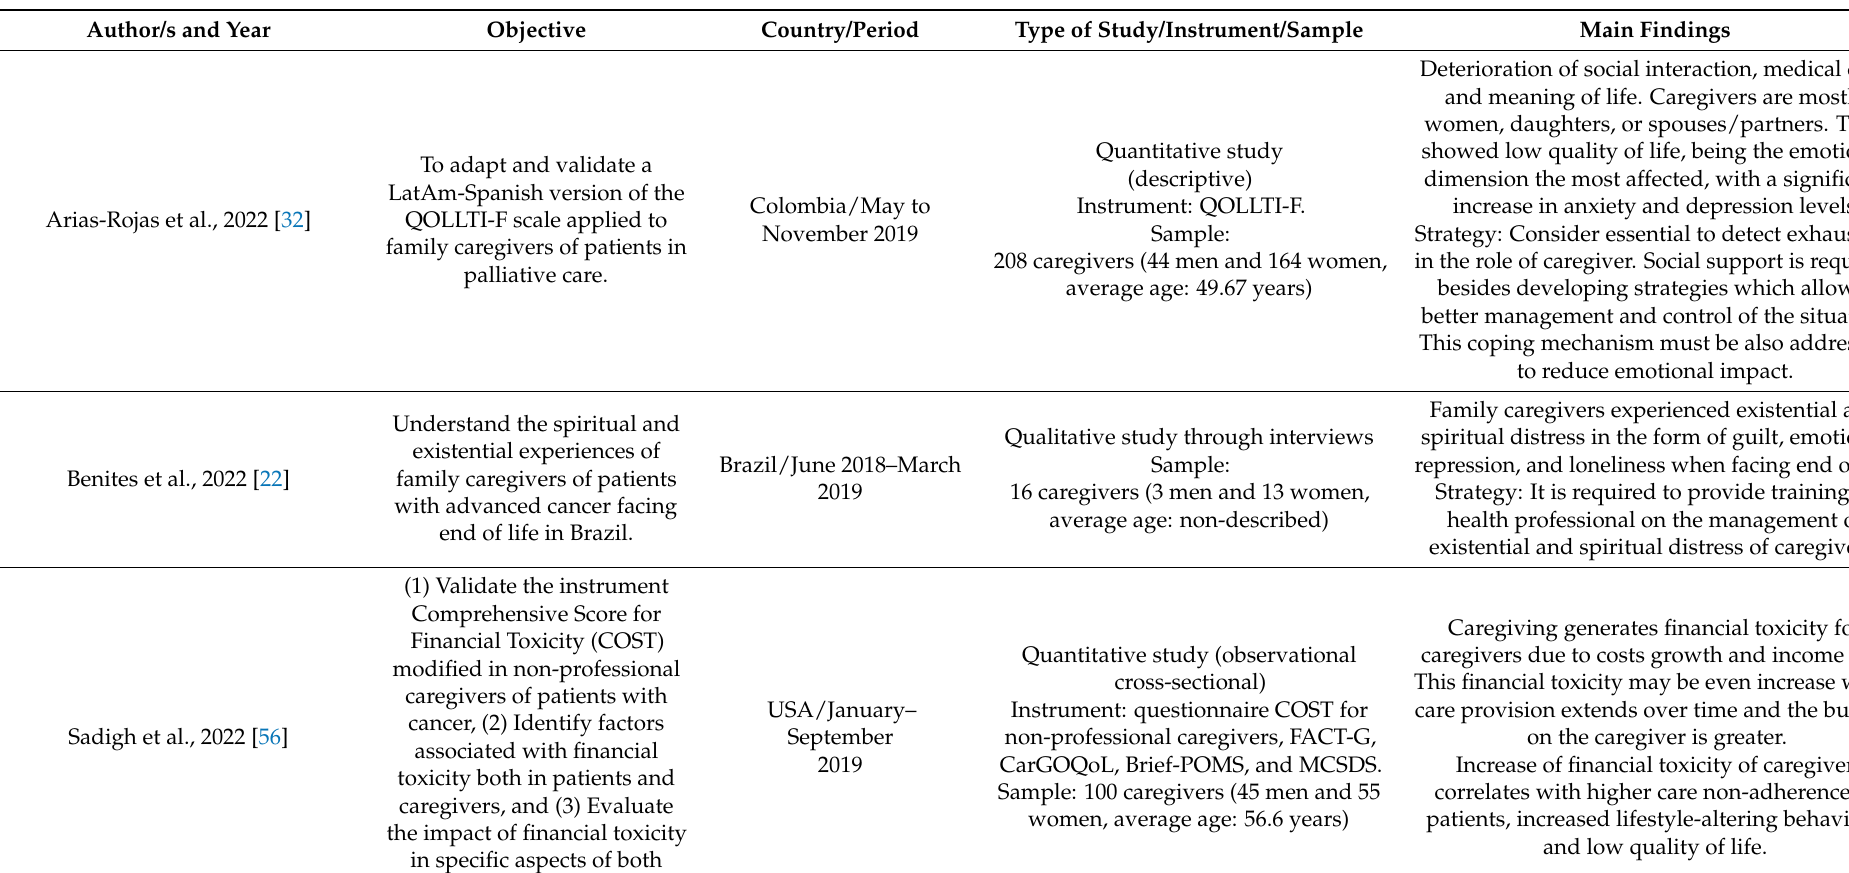
Table 1. Characteristics of the selected